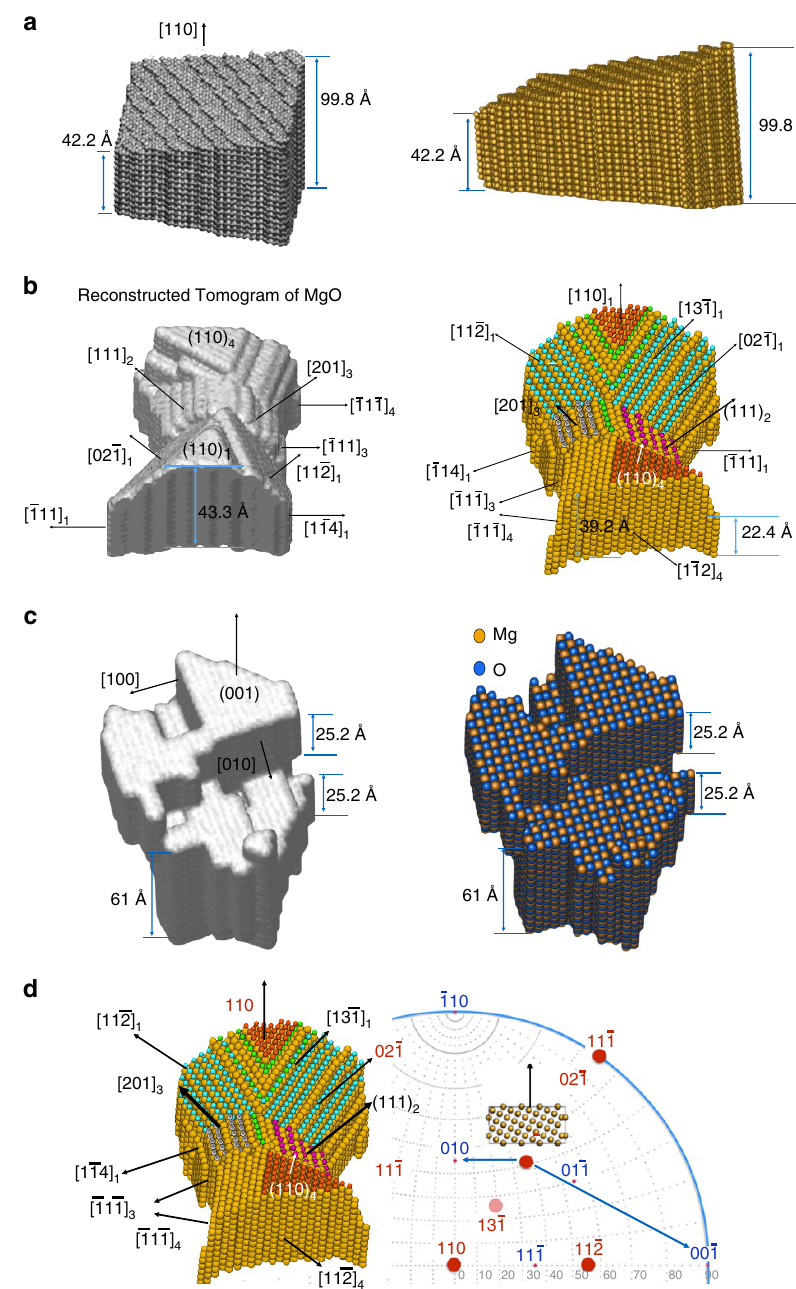
Figure 4 | Atomic resolution tomograms. ( a ) Surface shape and atomic structure views of the Ge [110] sample. ( b ) Surface shape and atomic structure views of the Au[110] sample. The facets are highlighted with different colours. ( c ) Surface shape and atomic structure views of the MgO [100] sample. Orange atoms: Mg, blue atoms: O (the size of the atoms is intentionally enlarged to render the shape of the particle). ( d ) The Wulf net shows the relationship of the high-energy facets (red dots) with low indexed facets for four grains indexed with i ¼ 1 y 4. In grain 1, a [02 (cid:2) 1] surface facet can be formed by low energetic [010] and [00 (cid:2) 1] (red symbols) surfaces as shown by the insets and observed in the